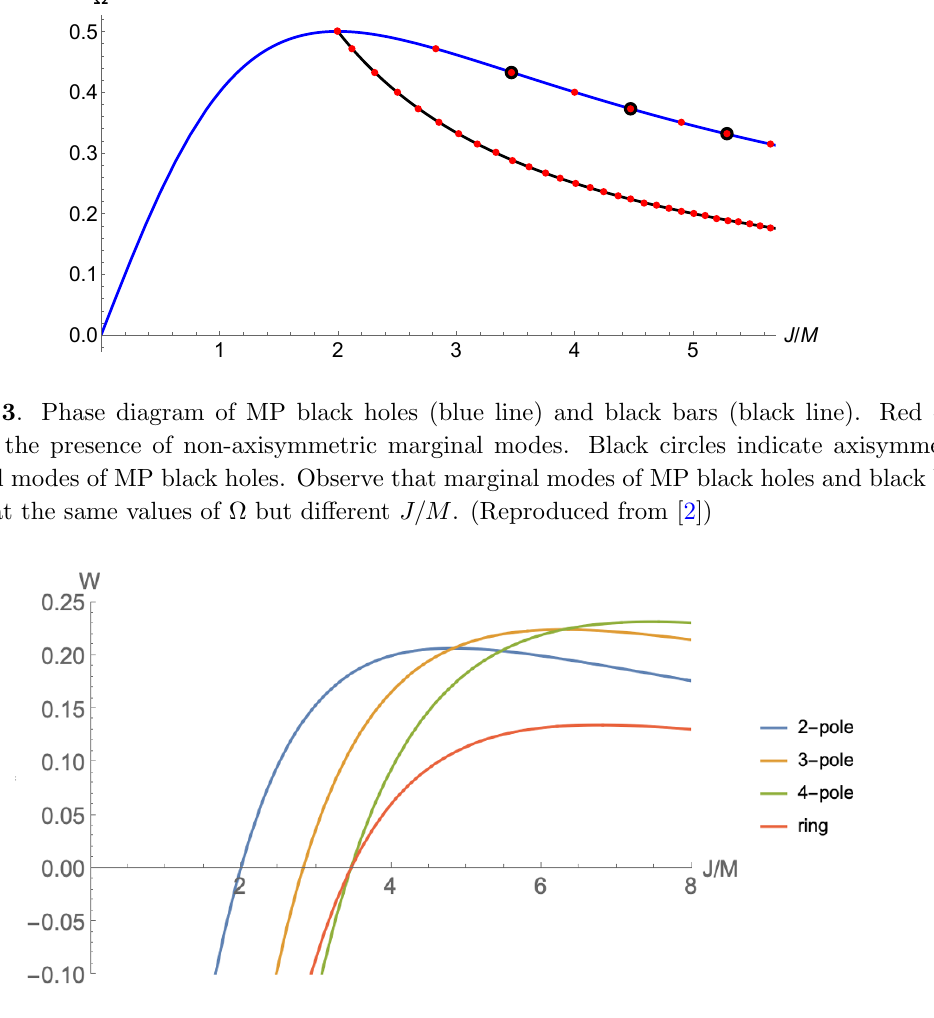
Figure 4 . Growth rates W of unstable modes of MP black holes at D ! 1 , as a function of the spin per unit mass J=M of the black hole (as calculated in [2, 21]). Higher non-axisymmetric modes (‘ m (cid:30) -poles’) become successively dominant as the spin grows, and generically overwhelm the development of axisymmetric ‘ring’